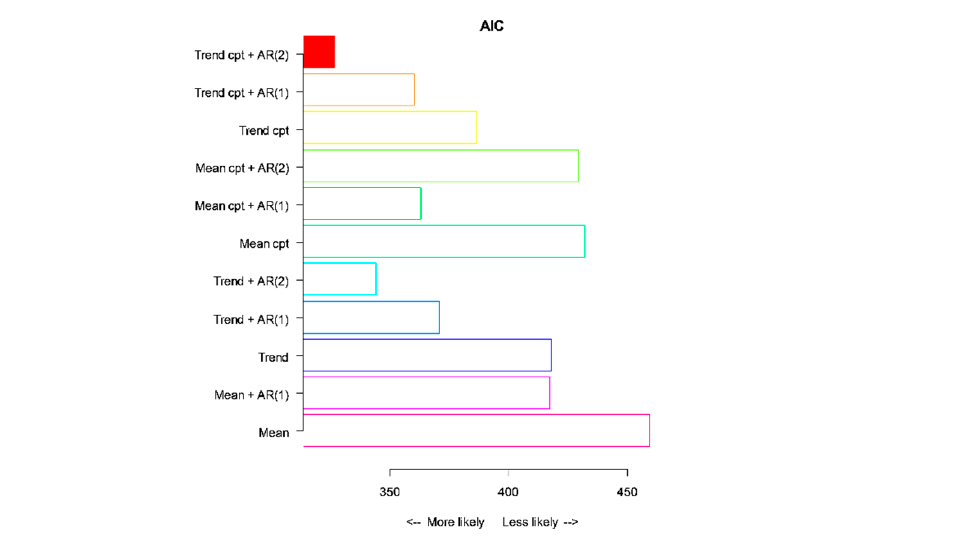
Figure 3. AIC values of different change-point models for the students studying abroad. Table 2. The results for students studying abroad